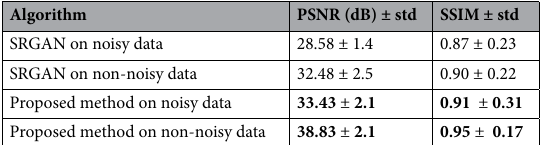
Table 9. Results on noisy images. Significant values are in